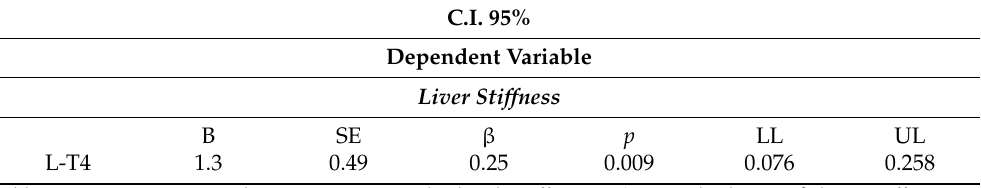
Table 3. Step-wise, multivariable linear regression analysis- factors associated with Liver Stiffness.